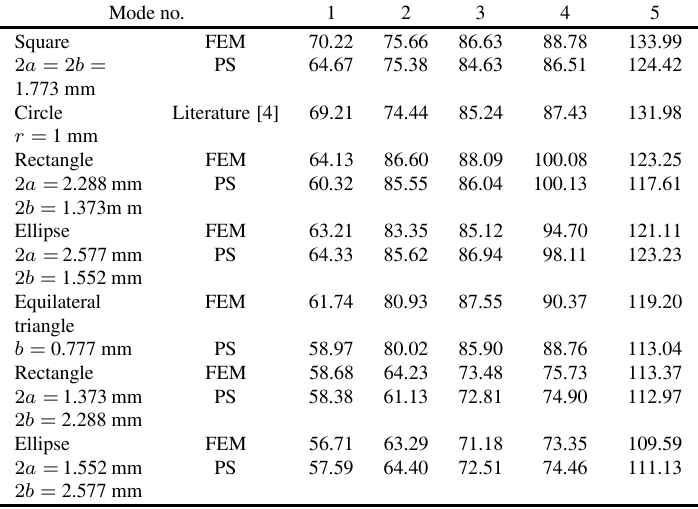
Table 4 First fi ve natural frequencies of conical type spring with four cross-sectional